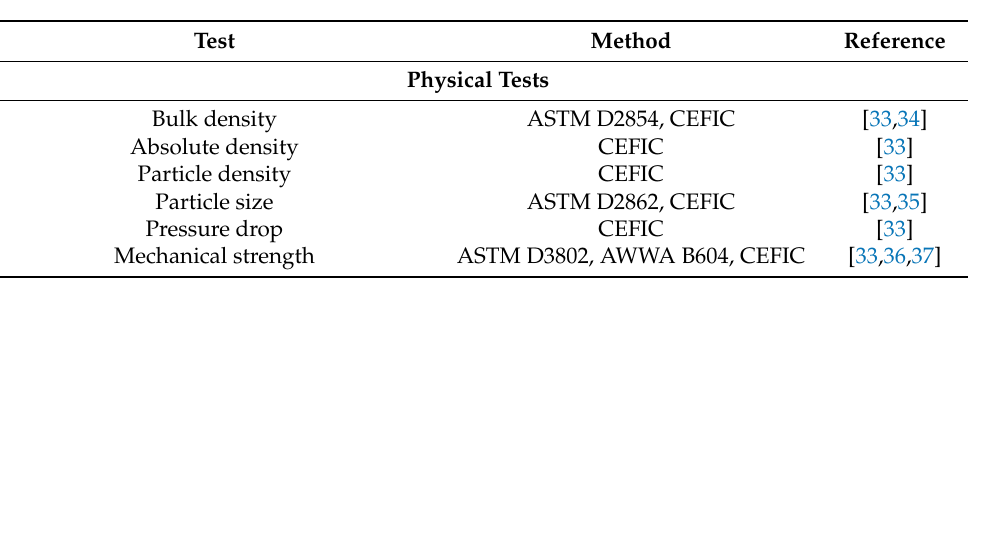
Table 1. Standard methods for the characterization of activated